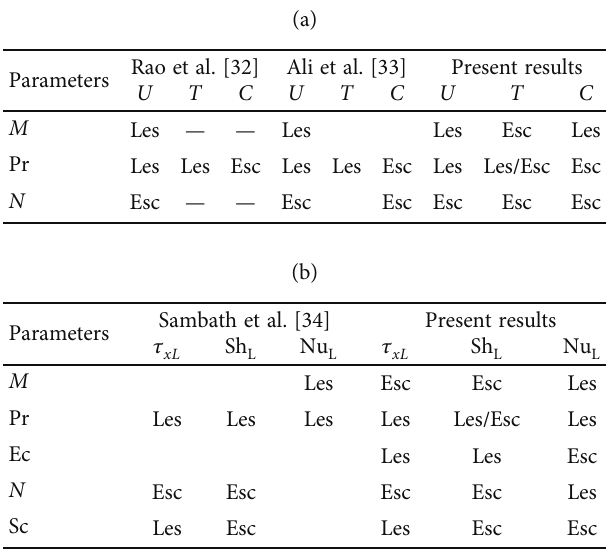
Table 14: Comparison of the current fi ndings qualitatively to other published results.